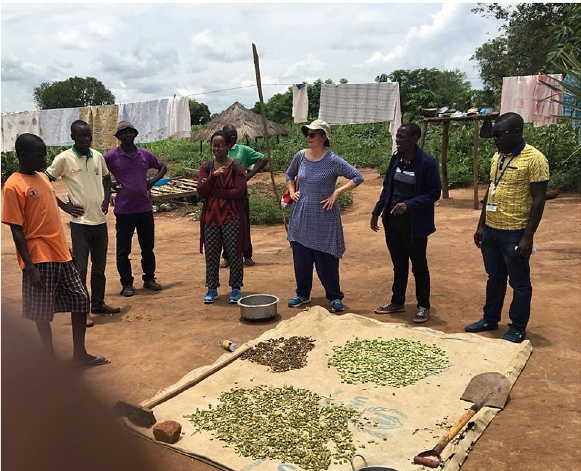
Fig. 1 Sun drying of okra by refugees in Rhino camp in Arua,